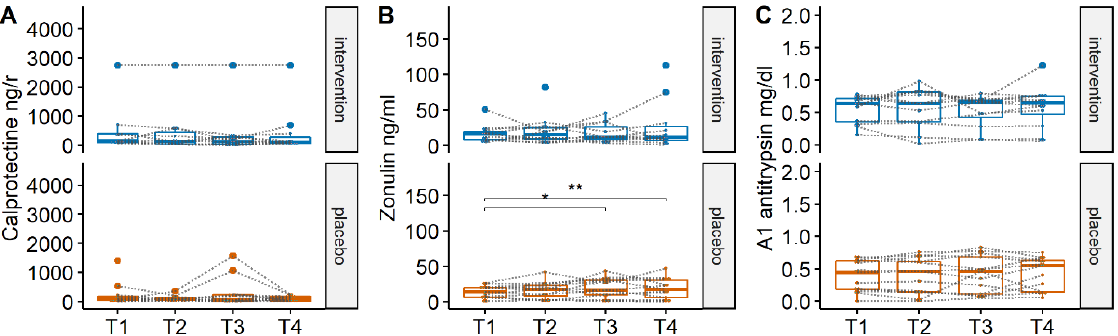
Figure 4. Concentrations of ( A ) calprotectin, ( B ) zonulin and ( C ) antitrypsin detected in the fecal water of the samples between the two groups. No significant differences were detected between the two groups in any of the markers tested. *, ** A significant difference was detected only for zonulin which increased in the placebo group. The boundaries of the box on the bottom indicate the 25th percentile, the line within the box represents the median, and the boundary of the box on the top the 75th percentile, and data from individual participants are connected by dotted lines. Differences between groups and within groups were calculated using Linear mixed effects models.